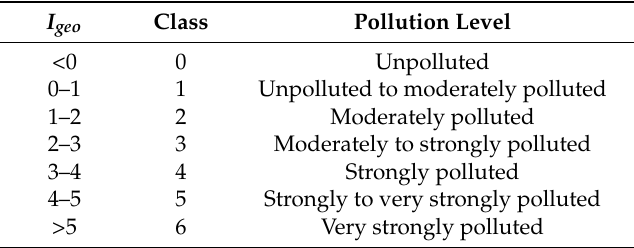
Table 1. Classification of Index of geo-accumulation ( I geo )